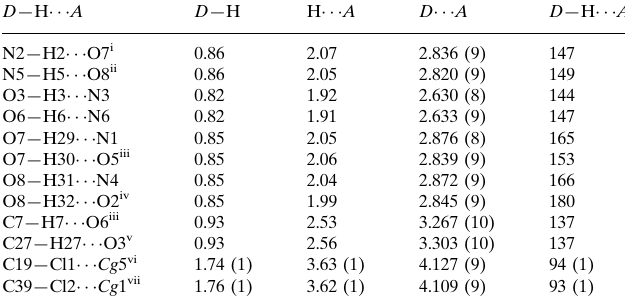
Data collection Bruker SMART CCD area-detector diffractometer Absorption correction: multi-scan ( SADABS ; Sheldrick, 1996) T min = 0.929, T max = 0.977